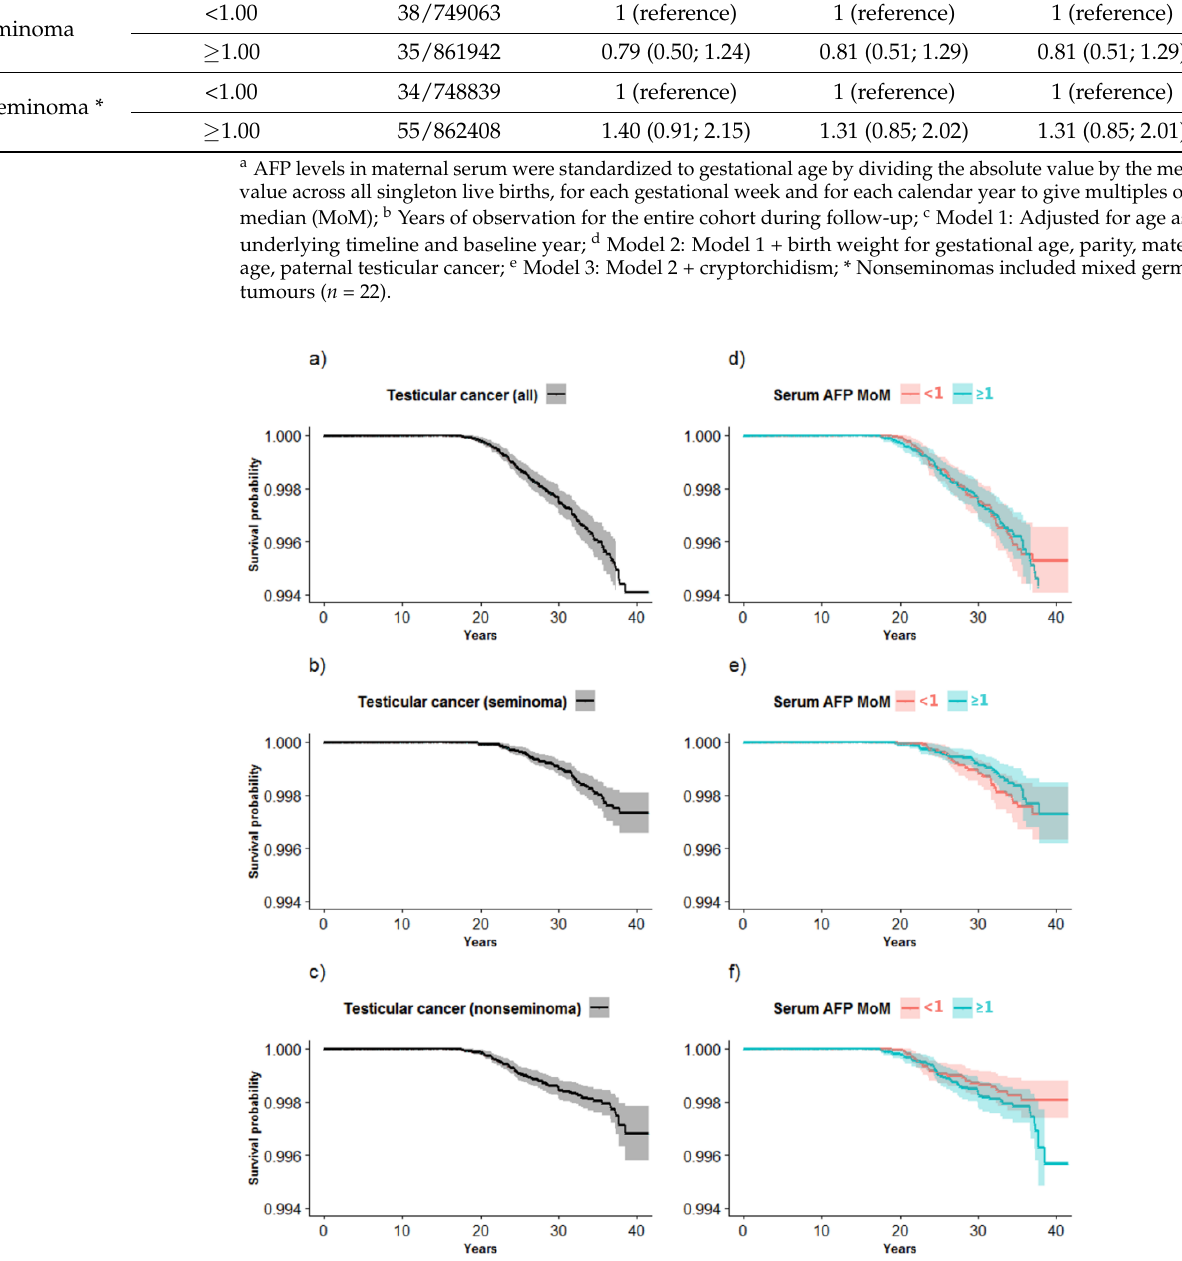
Table 3. Serum AFP ** and risk of testicular cancer (all) in offspring stratified by age, reproductive variables and other covariates in the cohort of 50,519 Danish singleton males and mothers stratified by AFP multiples of the median (MoM). Overall